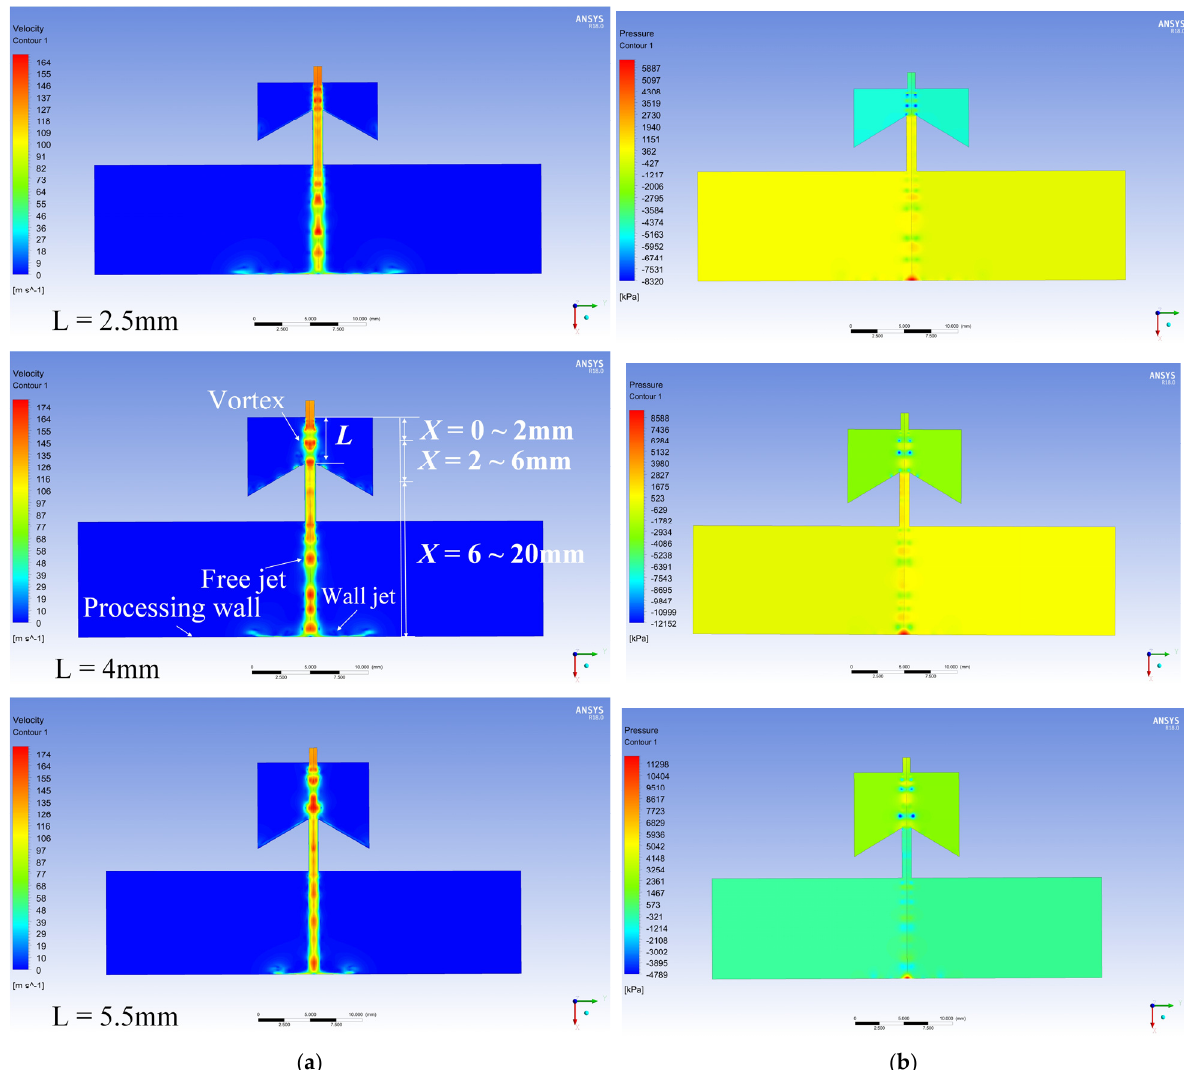
Figure 5. Flow field velocity and pressure contour under three cavity lengths. Velocity contour ( a ). Pressure contour ( b ).